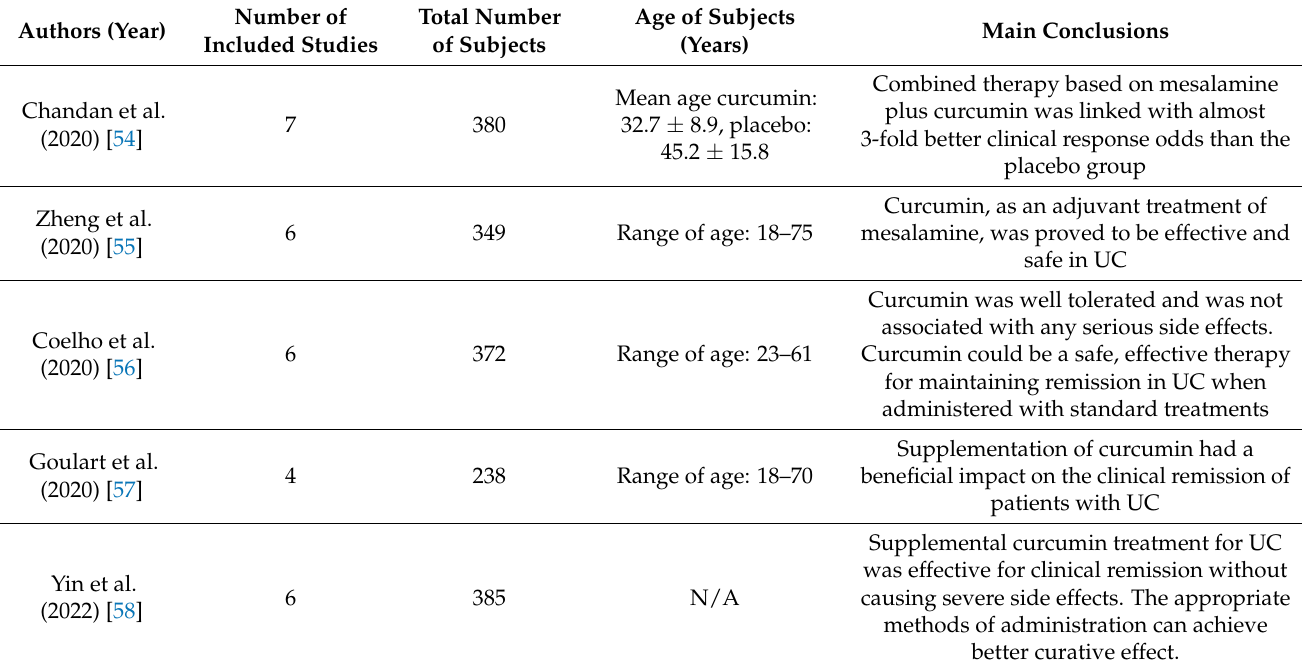
Table 1. Characteristics of the included systematic reviews and